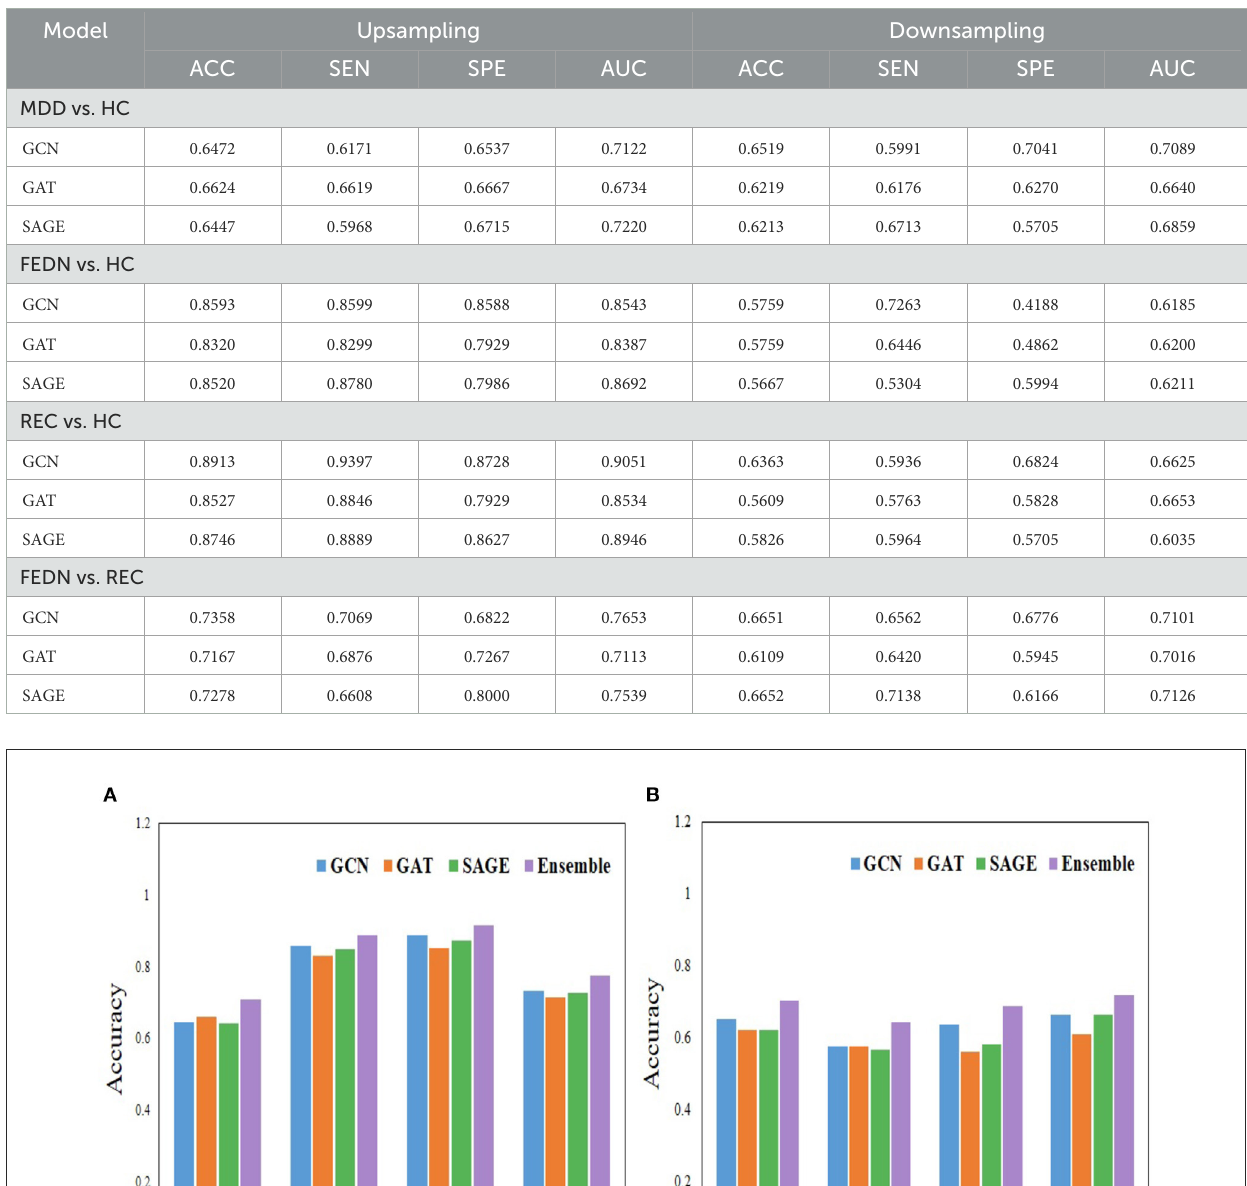
TABLE 4 Base model performance under different group analysis. Model